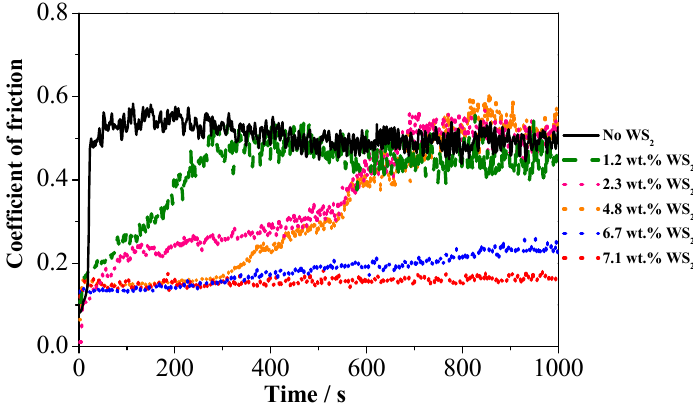
Figure 6. Relationship between friction coefficient and sliding time for the Ni–Co/WS 2 with different